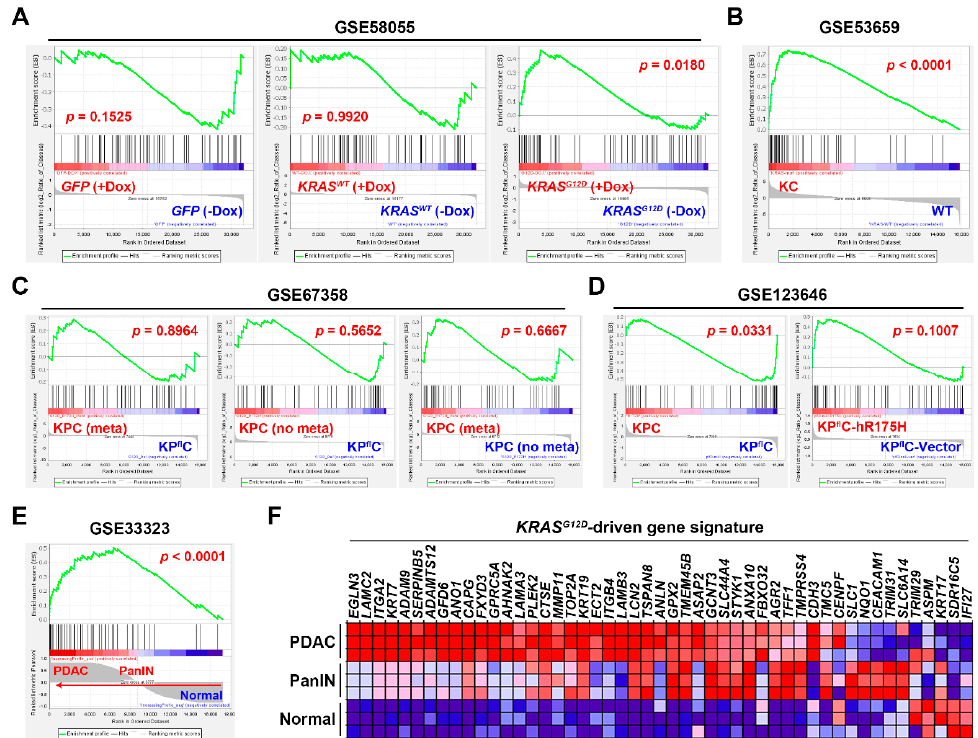
Figure 5. The association between KRAS / TP53 gene mutations and pancreatic ductal adenocarcinoma